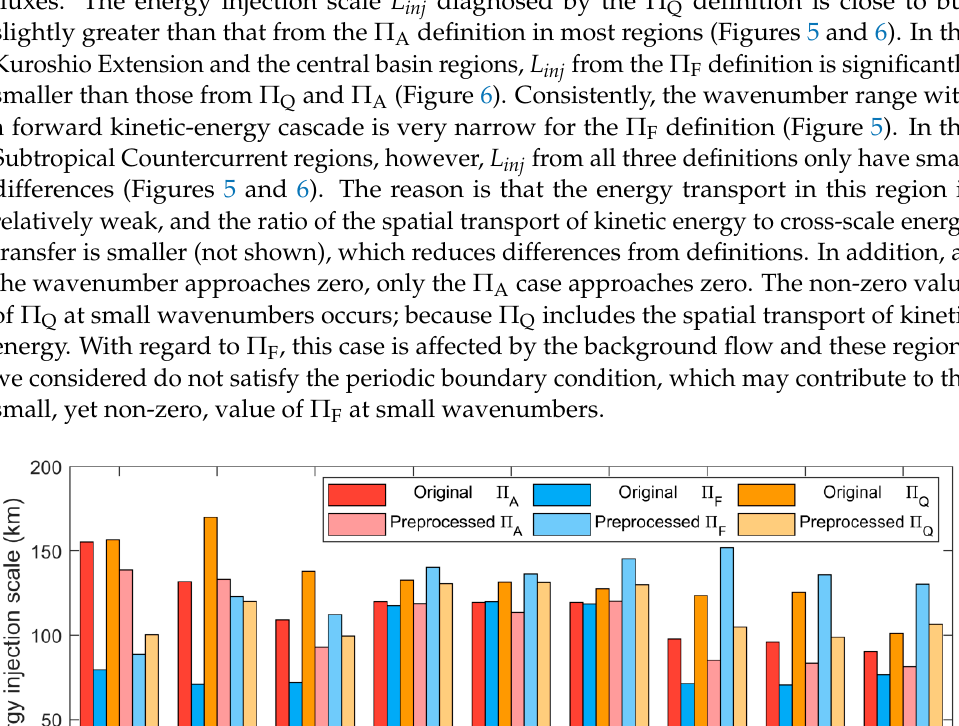
12 of 23 Figure 5. Time-mean surface spectral kinetic-energy flux Π A , Π F , and Π Q in the nine subregions marked in Figure 2. Each box has 40×40 grid points. Results here are estimated from the original velocity data without preprocessing. One, all three have their largest amplitude in the Kuroshio Extension, followed by that for the Subtropical Countercurrents, and their smallest in the central basin of the